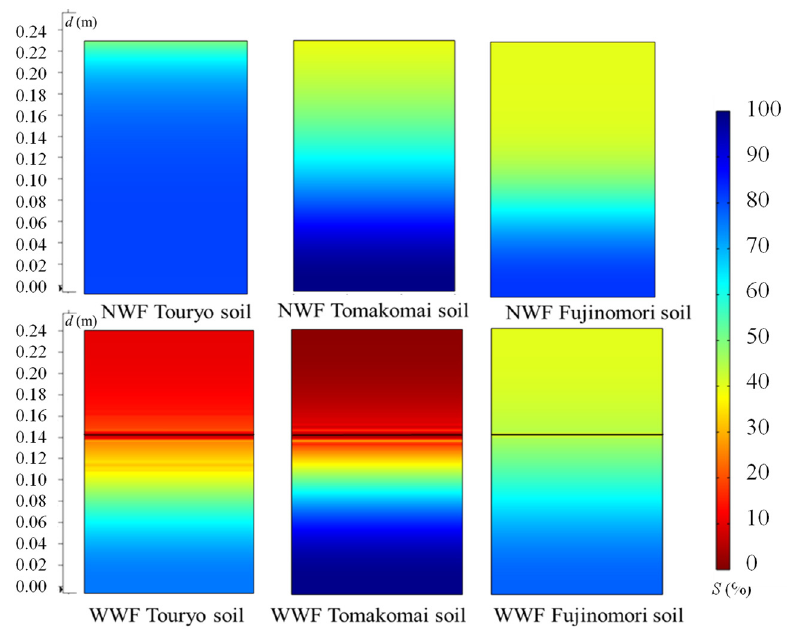
Figure 11. Effect of soil types on frost heave and WF inhibiting effect. Figure 11. Contour plot of Effect of soil types on frost heave and WF inhibiting